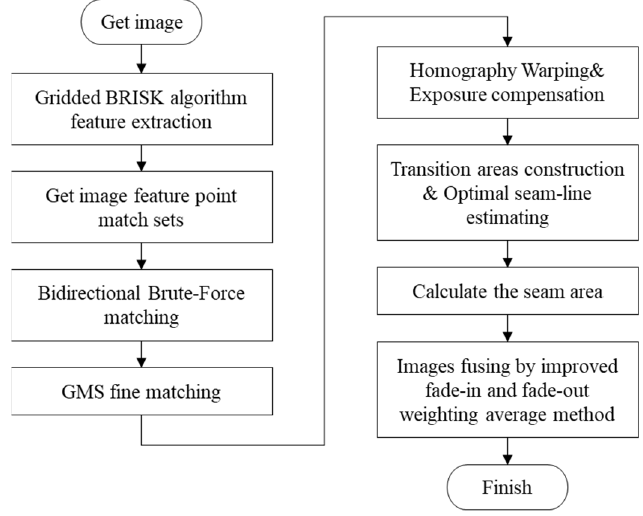
Figure 6. The image stitching process in this paper.